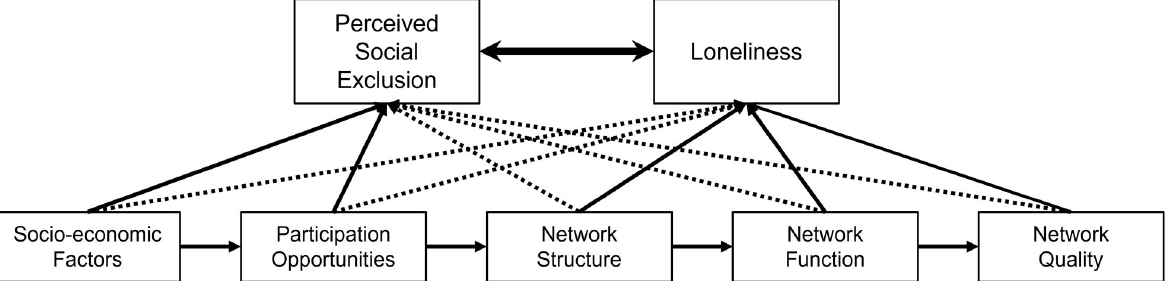
Figure 1: Conceptual model of shared risk factors of perceived social exclusion and loneliness. Notes: Solid lines indicate strong associations. Dotted lines indicate weaker